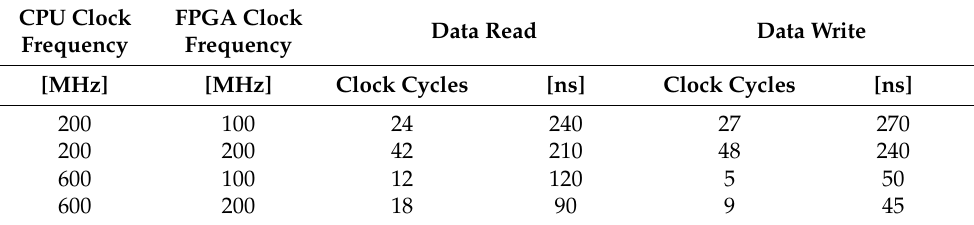
Table 1. The AXI crossbar performance for data transfer between CPU and FPGA